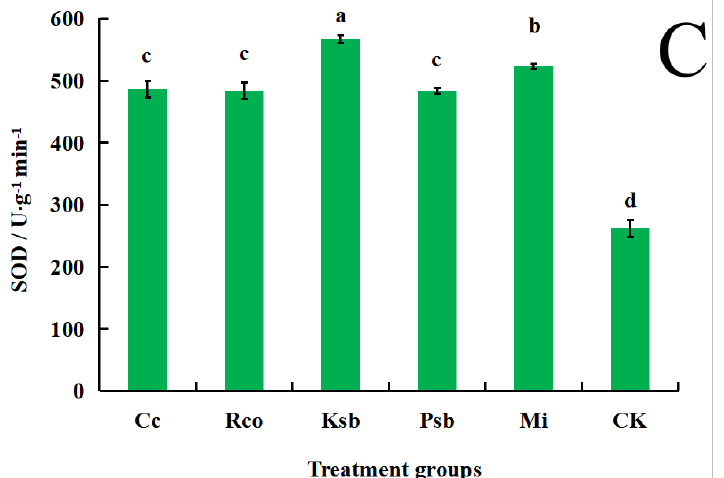
Figure 2. Effects of different microbial inocula on the CAT (catalase), POD (peroxidase), and SOD (superoxide dismutase) enzyme activities of F. taipaiensis leaves. The values are means ± standard deviation of 5 plants randomly selected from each treatment. Different lowercase letters indicate significant differences ( p < 0.05). ( A ) CAT contents in the leaves of each treatment group. ( B ) POD contents in the leaves of each treatment group. ( C ) SOD contents in the leaves of each treatment group. Cc: Claroideoglomus claroideum treatment group, about 1360 C. claroideum spores for each container; Rco: Racocetra coralloidea treatment group, about 1430 R. coralloidea spores for each container; Ksb: potassium solubilizing bacteria treatment group, 35 g Bacillus mucilaginosus inoculum for each container; Psb: phosphorus solubilizing bacteria treatment group, 35 g Bacillus megaterium inocu- lum for each container; Mi: mixed treatment group with mixed inoculum of C. claroideum , R. coral- loidea , B. mucilaginosus , and B. megaterium , the application amount of each microbial inoculum